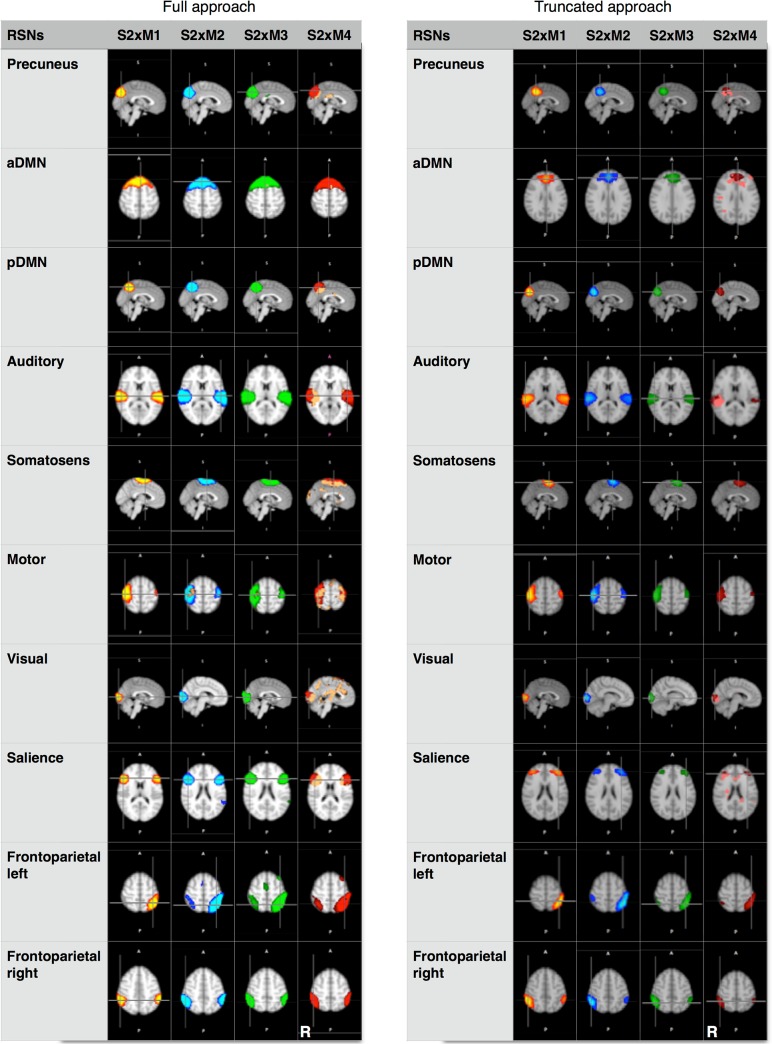
Spatial representation of the ten representative resting state networks.Networks were obtained from full (left panel) and truncated (right panel) data sets for different M-factors (S2×M1: yellow, S2×M2: blue, S2×M3: green; S2×M4: red). Please note the strong variability of networks at M4 indicated by voxel-wise differences at p<0.05 corrected for TFCE (orange voxels in red column).